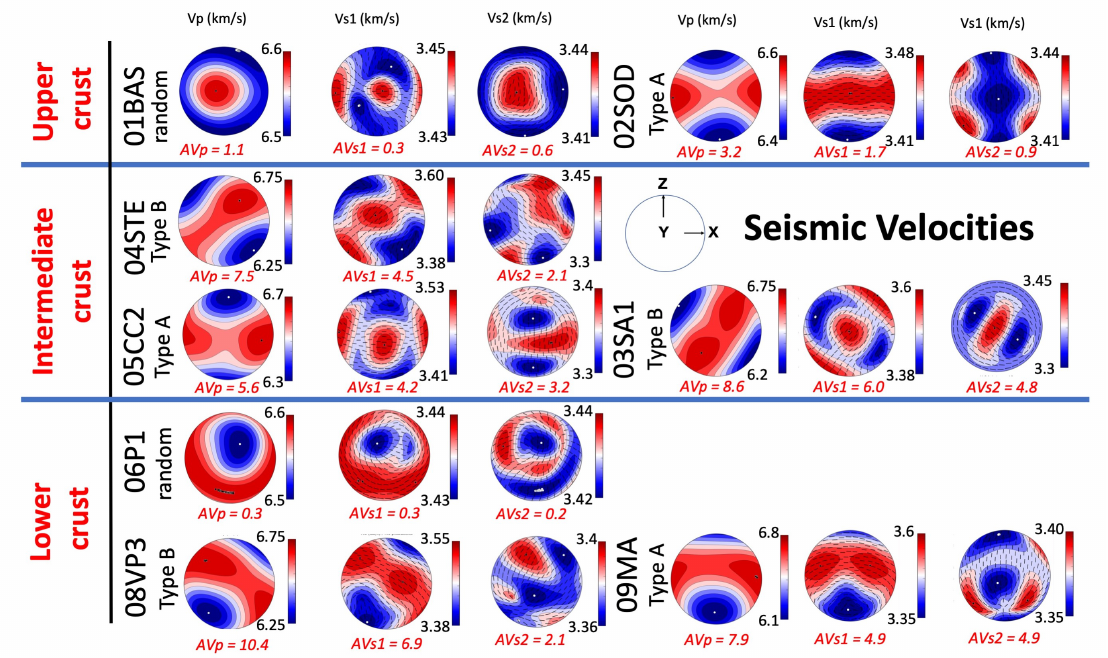
Figure 6. Vp(km/s), Vs1 (km/s), and Vs2 (km/s) seismic waves velocities for the studied samples. Anisotropy for Vp (AVp), Vs1 (AVs1), Vs2 (AVs2) are calculated as A = 200 · (maxV − mivV)/(maxV + minV). For AVp V = Vp, for AVs1 V = Vs1, for AVs2 V =